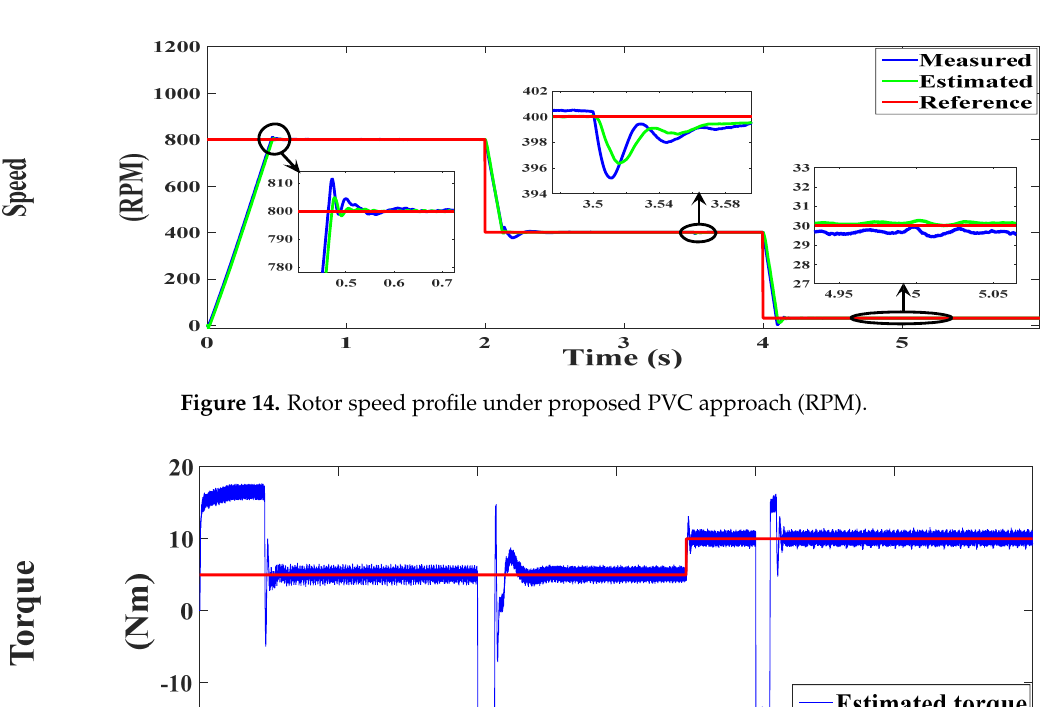
Figure 16. Stator flux profile under proposed PVC approach (Vs). ( a ) ( b ) Figure 17. ( a ). Alfa-component of rotor flux under proposed PVC approach (Vs), ( b ). Beta- component of rotor flux under proposed PVC approach (Vs).